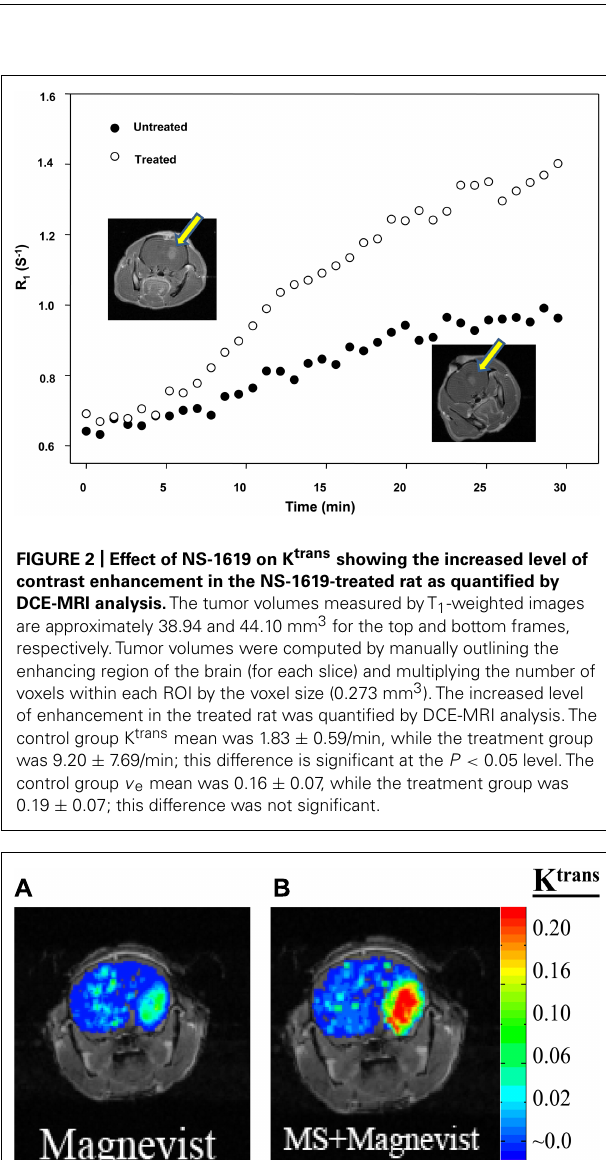
FIGURE 3 | Mouse with glioma (GL-261) was injected with 0.2 mmol/kg of MRI contrast agent Magnevist and DCE-MRI studies performed (A). After 24 h washout period the same mouse was given ATP-sensitive potassium (K ATP ) channel activator, minoxidil sulfate (MS) prior to Magnevist infusion (B)